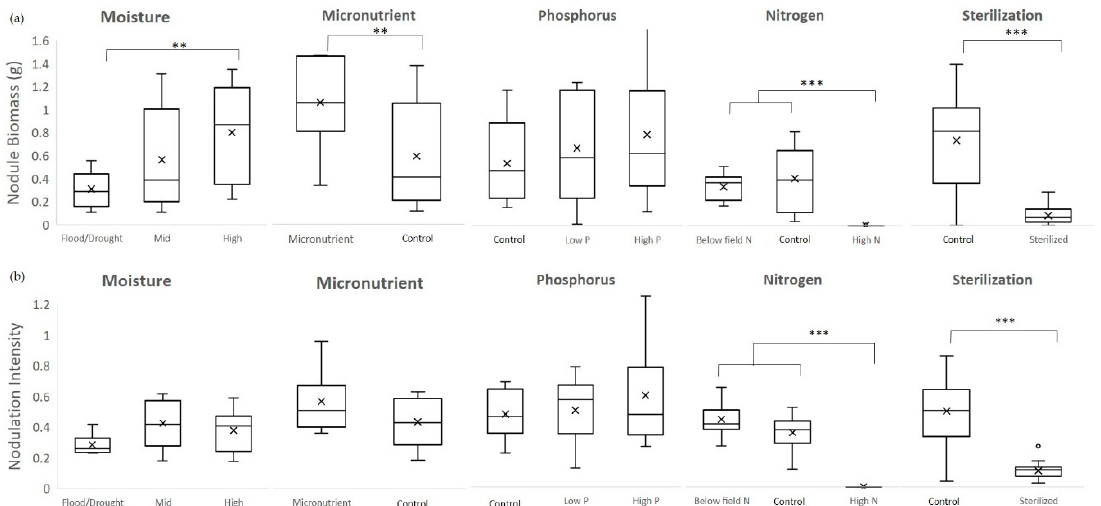
Figure 1. All experiments except phosphorus showed significant di ff erences in nodule biomass ( a ). High moisture significantly increased nodule biomass over saturation / drought cycle, while mid-range moisture significantly di ff ered from neither high nor cycle. Micronutrient addition increased nodule biomass while N addition completely inhibited it. There was no significant di ff erence between mean nodule biomass control N and low N. Soil sterilization significantly impeded nodule formation. For nodulation intensity (the ratio of nodule biomass to root biomass) only the nitrogen and sterilization experiments showed significant di ff erences with the same trends as nodule biomass ( b ). ** α ≤ 0.01, *** α ≤